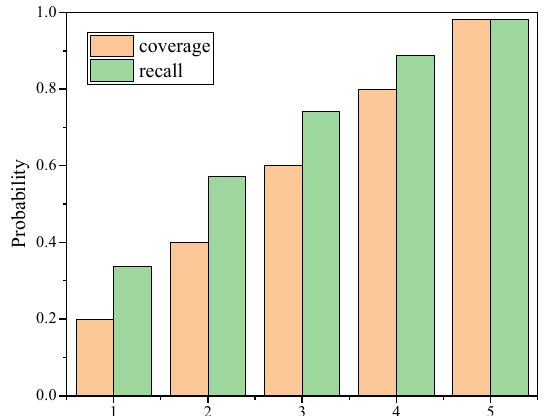
Figure 8. The relationship between recall and coverage.